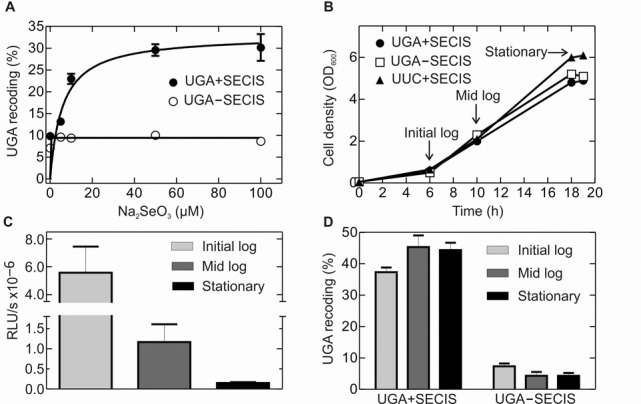
Dependence of UGA read-through on selenium source concentration and cell growth conditions. (A) Increase in UGA read-through with selenium supply. Cells were grown in TPG medium supplemented with different concentrations of Na2SeO3 as indicated. The efficiency of Sec incorporation was measured by comparing the luciferase activity ratios of Rluc/Fluc in constructs containing the UGA and UUC codons preceding the SECIS (Materials and Methods). (B) Growth curves of E. coli Tuner (DE3) cells transformed with test constructs in TPG medium containing 50 μM Na2SeO3. Protein expression was induced by IPTG addition. Times of protein expression induction are indicated (arrows). (C) Fluc activity at different growth rates as an indicator for protein expression given in relative luciferase units per min (RLU/s). (D) UGA-recoding efficiency at different growth rates calculated as in A.